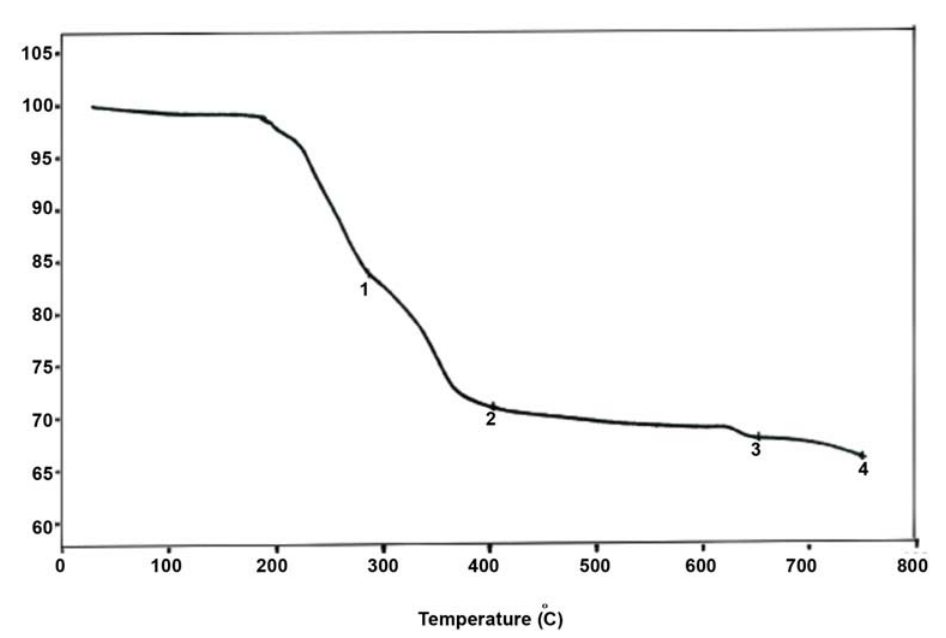
Figure 4. Thermogravimetric data for compound